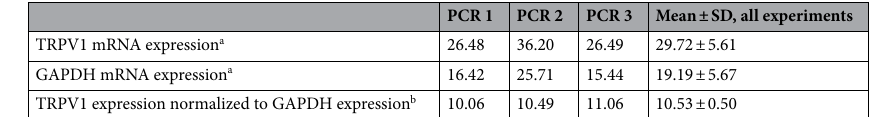
Table 1. TRPV1 mRNA expression in hiPSC-derived cardiomyocytes. Results of three independent experiments (PCR 1–3) of quantitative real time-PCRs. GAPDH expression was used as expression of a housekeeping gene for normalization. a Mean CT value of three technical replicates. b ΔCT = CT TRPV1 − CT GAPDH ; SD, standard deviation.